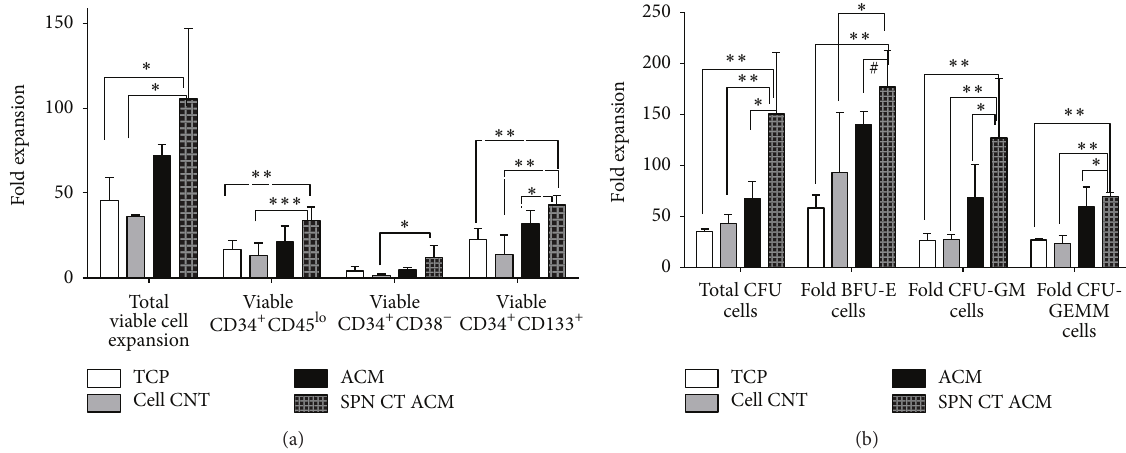
Figure 10: (a) Immunophenotypic analysis for measurement of fold increase in UCB HSPC of different lineages after expansion on native ACM, spin coated ACM, TCP, and cellular control. The graphs represented in the figure are the means of three independent experiments. ( ∗ 𝑝 ≤ 0.05 , ∗∗ 𝑝 ≤ 0.005 , ∗∗∗ 𝑝 ≤ 0.001 , # nosignificance,and 𝑛 = 3 ).(b)FunctionalanalysisoffoldexpansionofUCBHSPCbycolonyforming unit assay for CFU-GM, CFU-GEMM, and BFU-E as progenitor cell population on native ACM, spin coated ACM, TCP, and cellular control. ( ∗ 𝑝 ≤ 0.05 , ∗∗ 𝑝 ≤ 0.005 , # no significance, and 𝑛 = 3